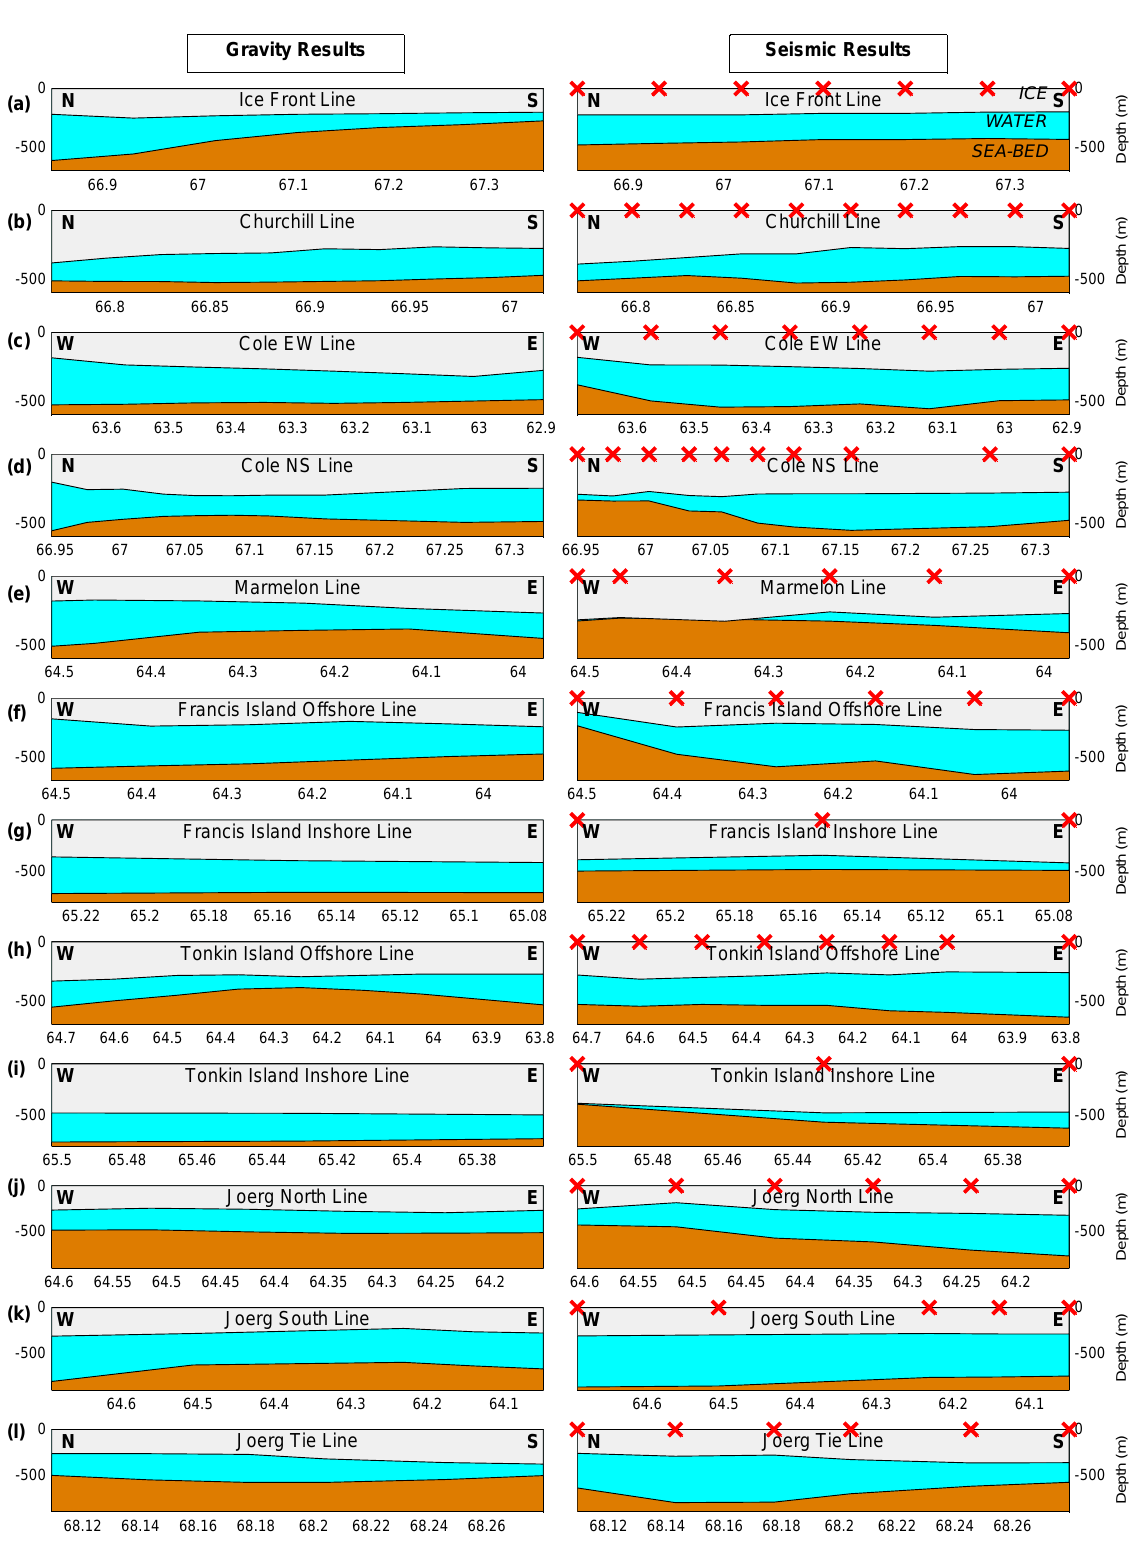
Fig. 6. Ice and sub-ice shelf cavity profile pairs comparing Cochran and Bell (2012) gravity inversion (left) and seismic (right) results. Red crosses indicate locations of seismic measurements. Vertical exaggeration varies between plots. The horizontal coordinate is latitude (S) or longitude (W) as